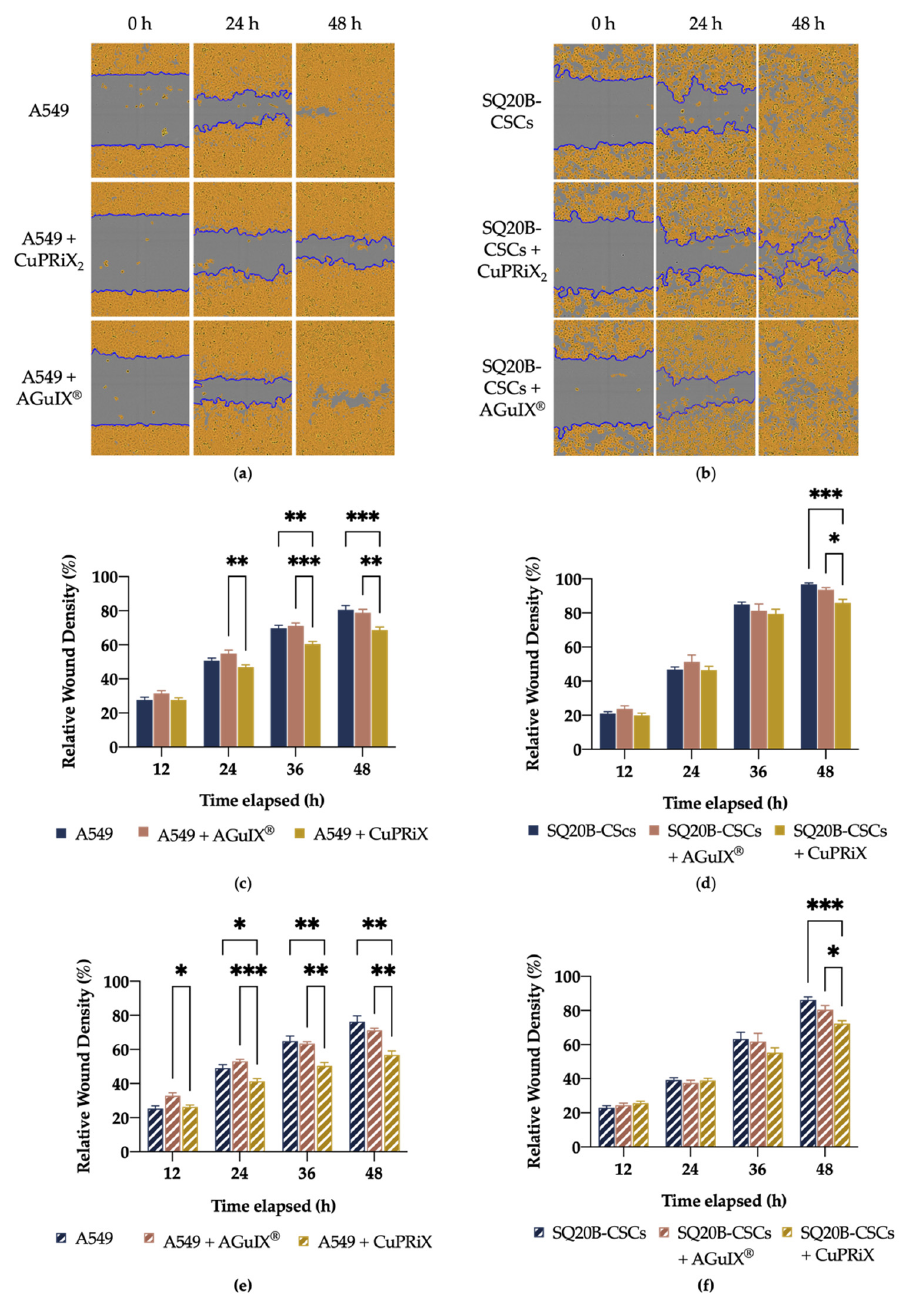
Figure 3. Effect of AGuIX ® and CuPRiX 2 on migration and invasion of A549 and SQ20B-CSCs with the scratch wound assay. Representatives images and quantitative analysis of migration of A549 ( a ), ( c ) and SQ20B-CSCs ( b , d ) cells after treatment with CuPRiX 2 (800 µM of DOTAGA(Gd) and 500 µM of uncomplexed DOTAGA) or AGuIX ® (800 µM of DOTAGA(Gd)). ( e , f ) Quantitative analysis of invasion (1 mg/mL of Matrigel) of A549 and SQ20B-CSCs cells, respectively, after treatment with CuPRiX 2 or AGuIX ® . Relative wound density is a measure of the density of the cell region (%). Data are presented as mean ± SEM ( n = 3) with 6 technical replicates for each experiment. * p < 0.05, ** p < 0.01, *** p < 0.001, two-way ANOVA.